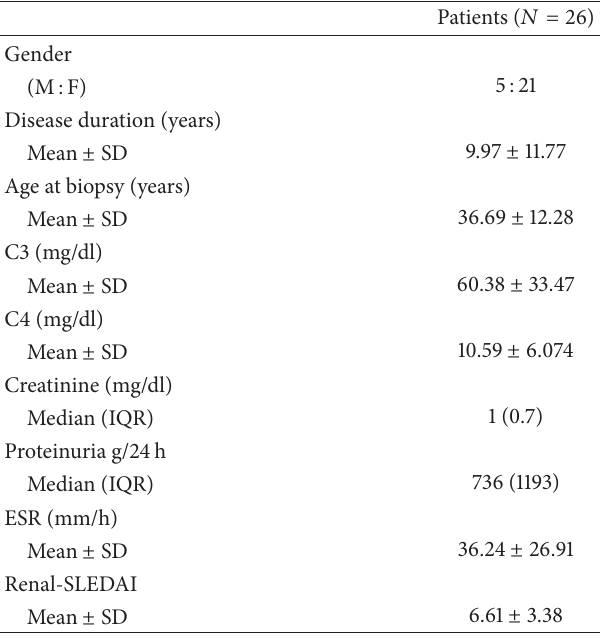
Table 1: Demographic and clinical data of the lupus nephritis